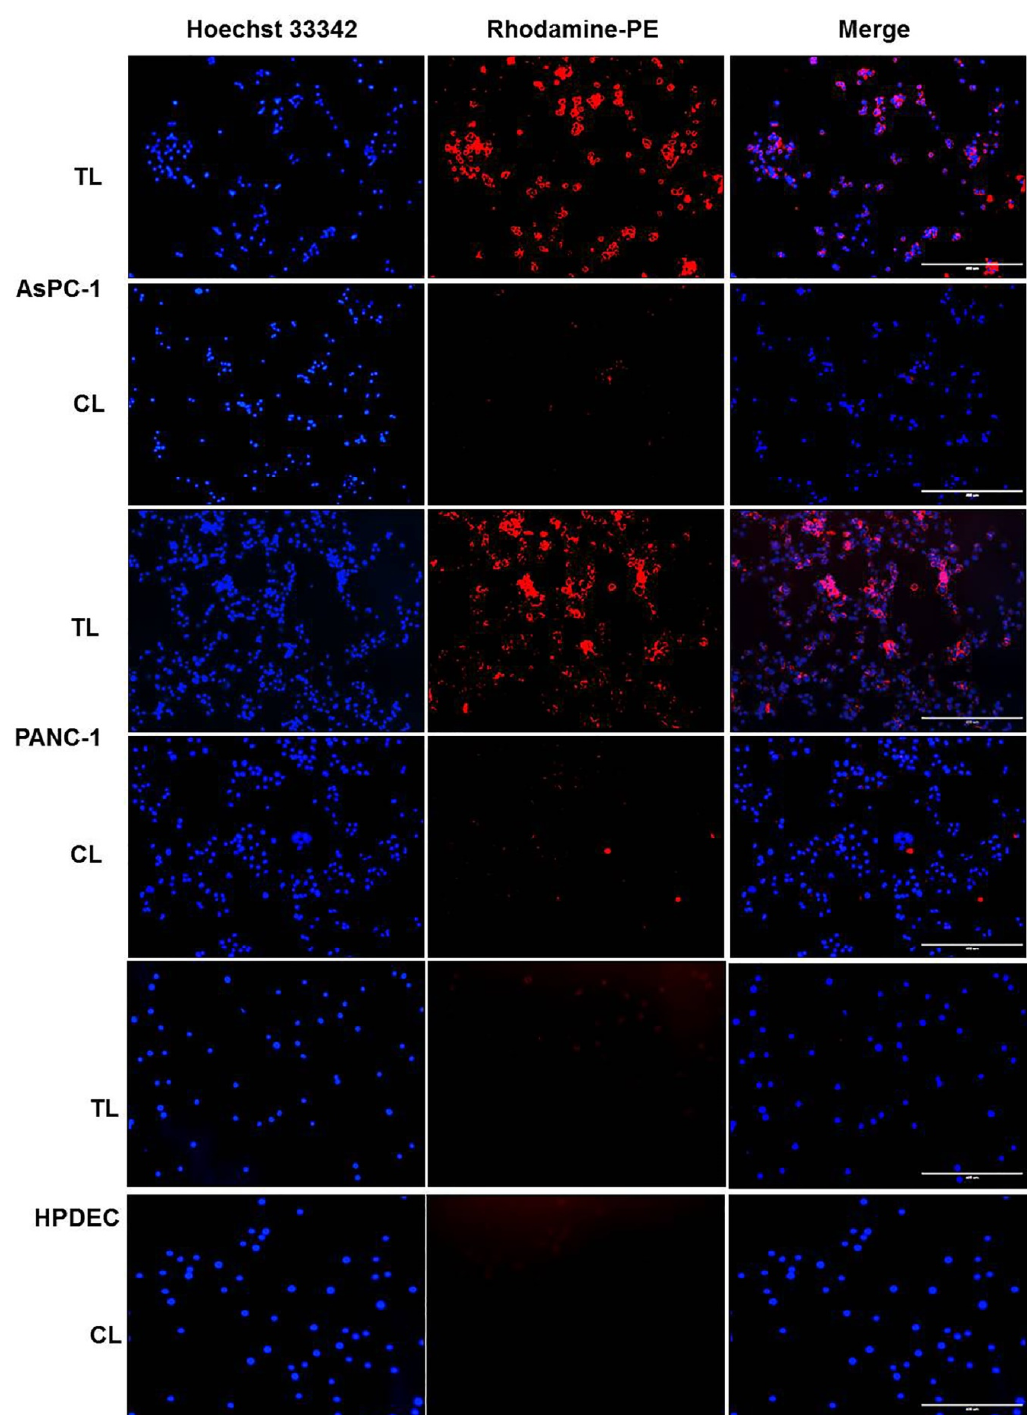
Figure 2. In vitro cellular uptake of Rhodamine-PE-labeled liposomes in pancreatic cancer cell lines. AsPC-1, PANC-1, and HPDEC cells were treated with Rhodamine-PE-labeled TTP-conjugated liposomes (TL) or control liposomes (CL) for 4 h. Nuclei of the cells were counterstained with Hoechst 33342 for the last 30 mins. Finally, cells were washed three times with PBS and images were captured using EVOS fluorescence microscope under the blue and red channels. TL-treated cells showed significantly higher uptake of Rhodamine dye compared to CL-treated cells in AsPC-1 and PANC-1 cells and very minimal uptake in HPDEC cells. Bar length = 400 µ m. Abbreviations: TL, tumor targeting peptide-conjugated liposome; CL, control